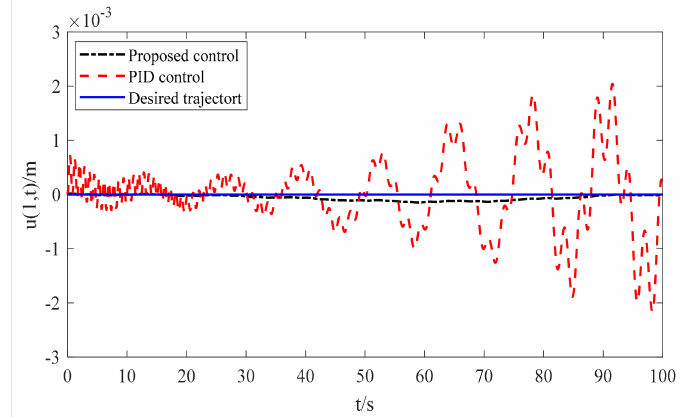
Figure 8. Performance comparison of active heave compensation.